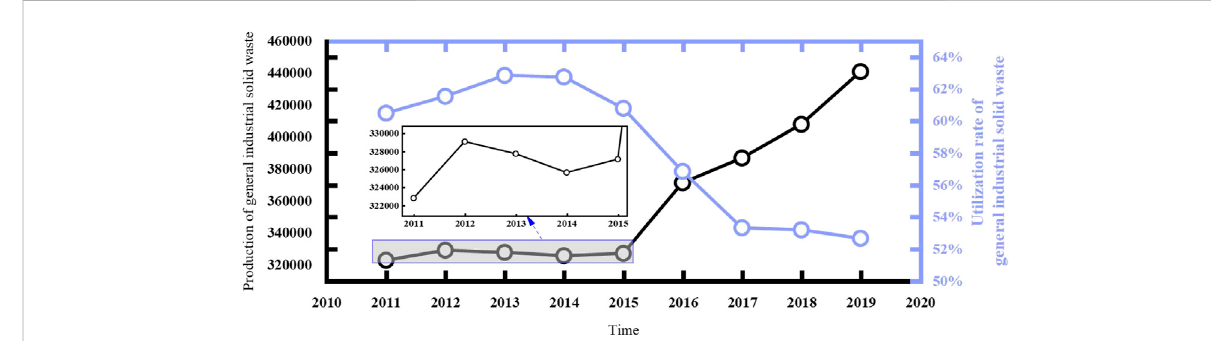
FIGURE 1 2011 – 2019 China ’ s general industrial solid waste production and comprehensive utilization rate.